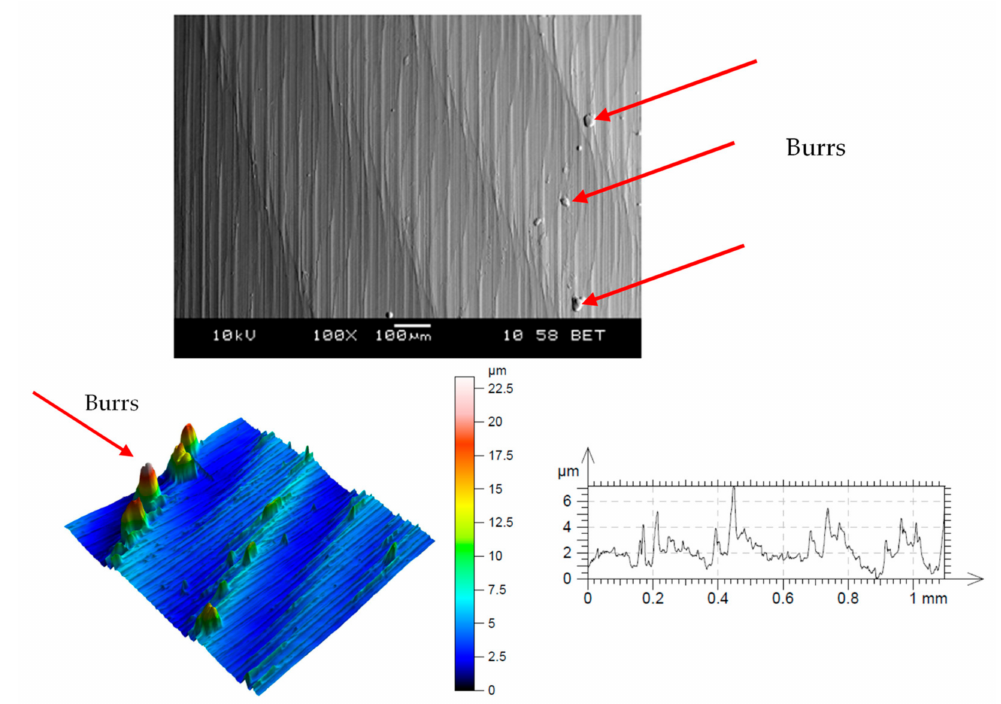
Figure 18. Microscopic image and topography of the machined surface with the R a characteristic (sintered nickel-cobalt alloy, VB < 0.2 mm, v c = 160 m/min, a p = 0.5